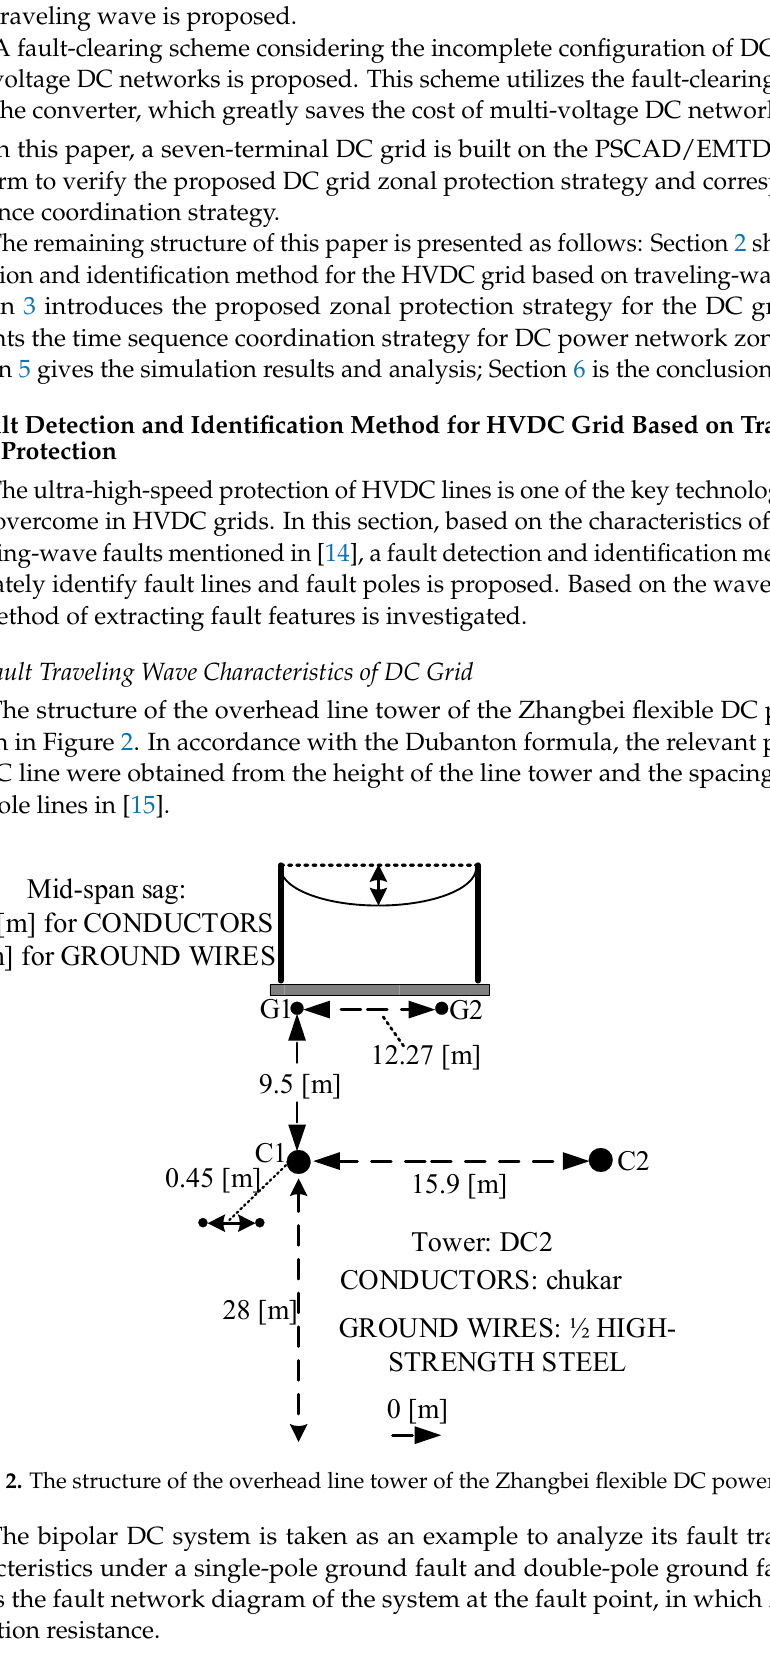
( c ) bipolar fault Figure 3. Fault points in the bipolar system. According to Figure 3, the modulus’ initial ‐ voltage ‐ fault traveling wave of the bipo ‐ lar DC system under positive, negative, and bipolar ground fault can be expressed as shown in Equations (1)–(3) [16]: